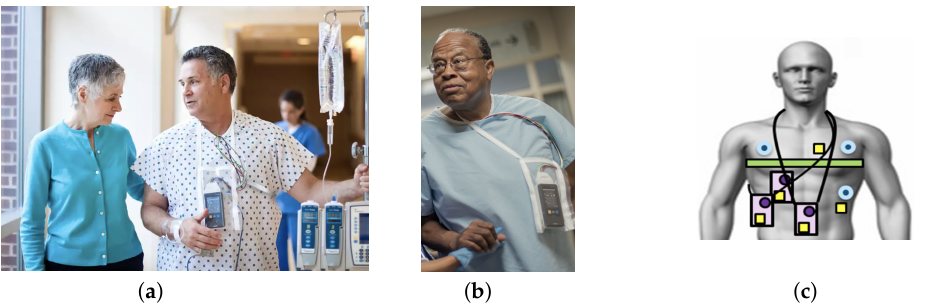
Figure 1. Patient monitoring device placement in the front ( a ) and side ( b ) positions [24,25]. ( c ) The sensor settings for the Wearing Position Study data collection. Yellow squares are GENEActive sensors: two in contact with the skin, two pending from the neck and one in the clinical gown pocket. Table